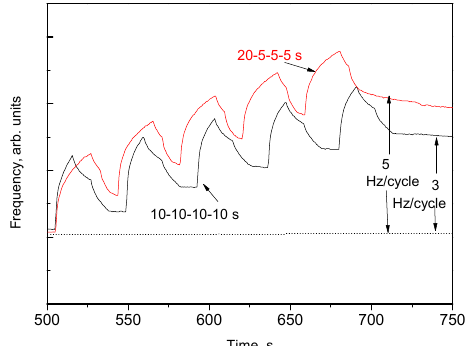
Figure 1. The illustrative image of quartz crystal monitoring (QCM) frequency change recorded during 5 atomic layer deposition (ALD) cycles with time parameters of 20-5-5-5 s (red line) and 10-10-10-10 s (black line) at 140 °C. Long cycle times were recorded to show the appropriate self-limiting ALD process. At the same time, shorter cycle times, like 2-2-2-5, were sufficient to deposit the films.